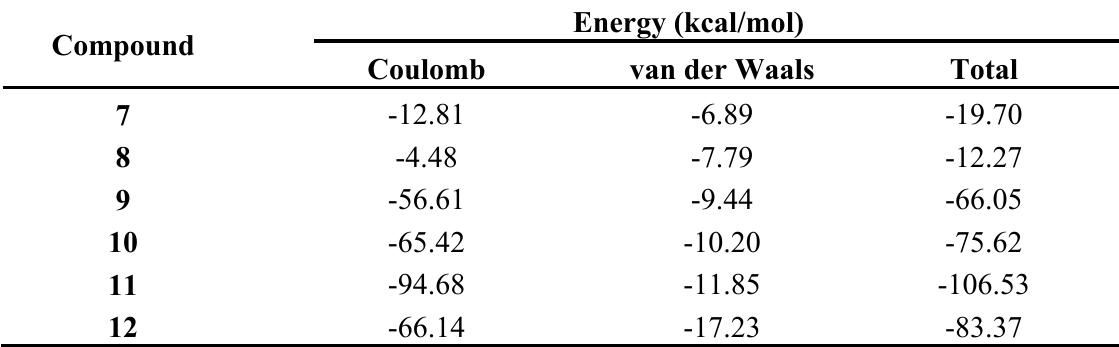
Table 4. Binding energy of kohamaic acid A derivatives (compounds 7 – 12 ) and the 8-kDa domain of DNA polymerase β .